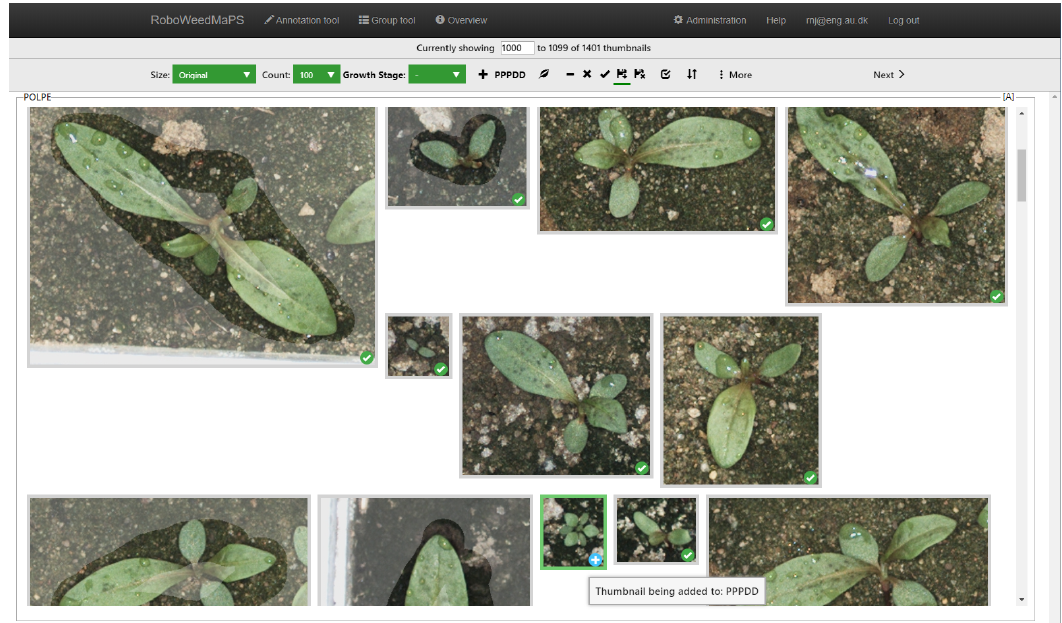
Figure 3. RoboWeedMaps’s correction tool feature used to manually verify the classification of POLPE (Persicaria maculosa, Redshank). The object with a white cross in a blue circle icon is being relabeled as PPPDD (dicotyledonous plants) class. Notice some objects are shaded as these are manually annotated, to correct for lacking or incorrect automatic bounding box